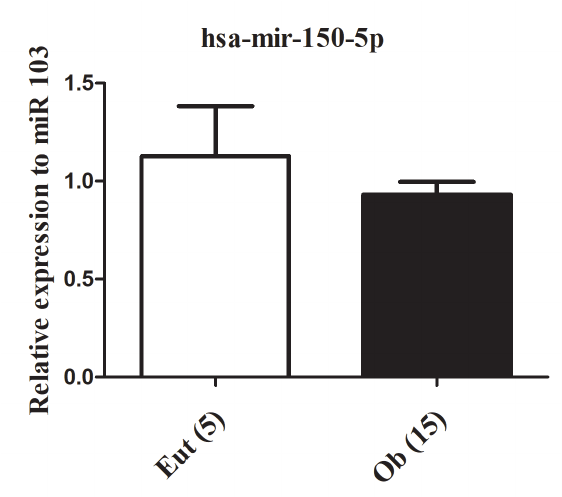
Figure 2. hsa-mir-150-5p (normalized to miR 103) expression profile in eutrophic and overweight/ obesity individuals. The graphic is presented as mean ± standard deviation. p 0.01. Eut, eutrophic; Ob,